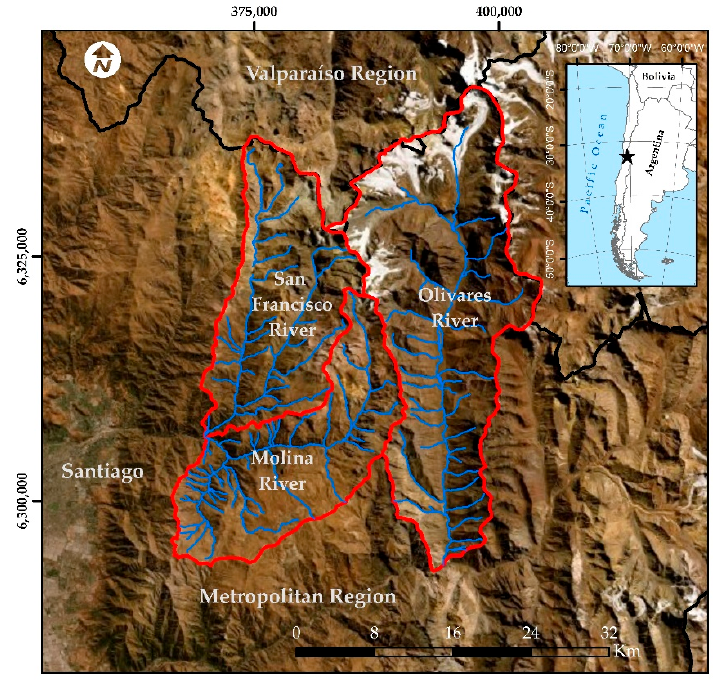
Figure 1. Location of the sub-basins of the San Francisco, Molina and Olivares rivers in the upper section of the Mapocho river